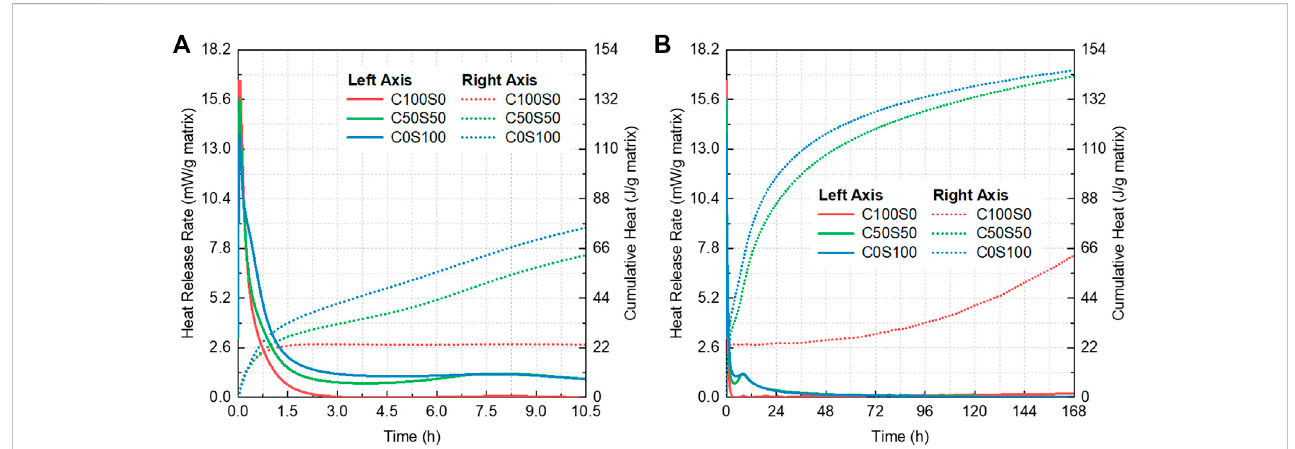
FIGURE 4 Reaction heat of SH-UHPGC pastes with different activators: (A) early-age reaction heat, (B) 7-d reaction heat.